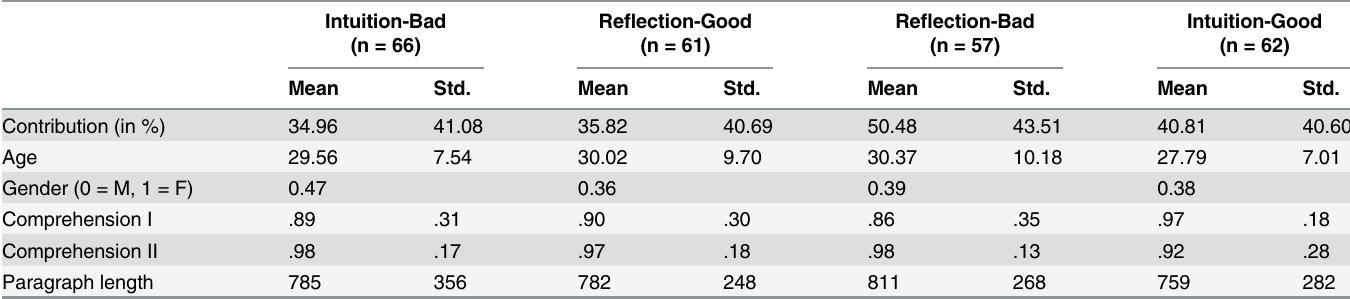
Table 1. Descriptive